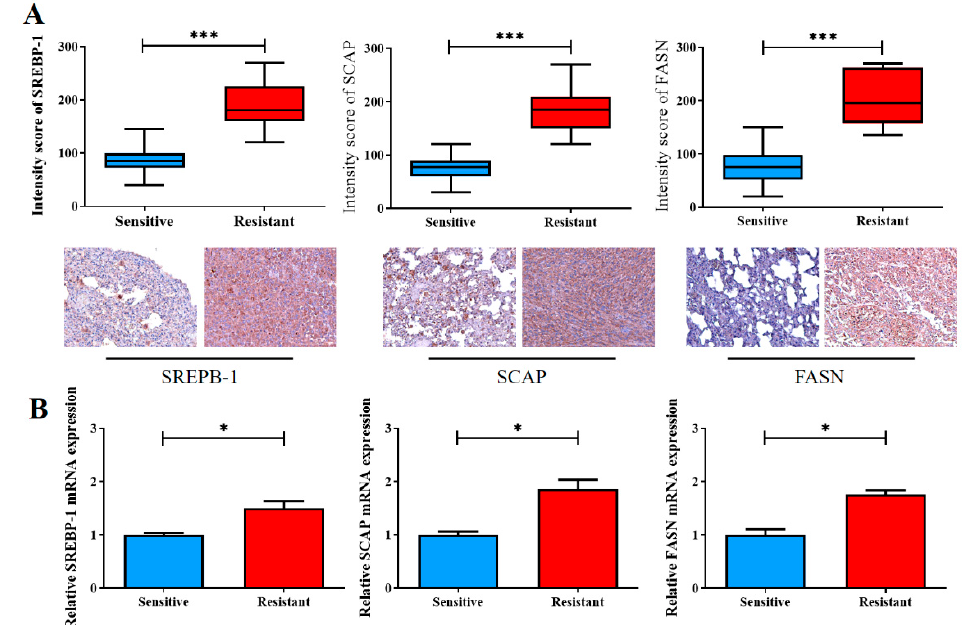
Figure 5. Enhanced SREBP-1/SCAP/FASN signaling is implicated in the reduced sensitivity of NSCLC cells to cisplatin therapy. ( A ) The staining intensity scores of the cisplatin-sensitive and cisplatin-resistant samples were compared. Graphical representations in boxplot and micro- graphs (with p values) indicating the SREBP-1, SCAP, and FASN levels in the cisplatin-sensitive and cisplatin-resistant samples. ( B ) The qRT-PCR analysis was used to measure the expression of SREBP-1/SCAP/FASN. * p < 0.05, and *** p <